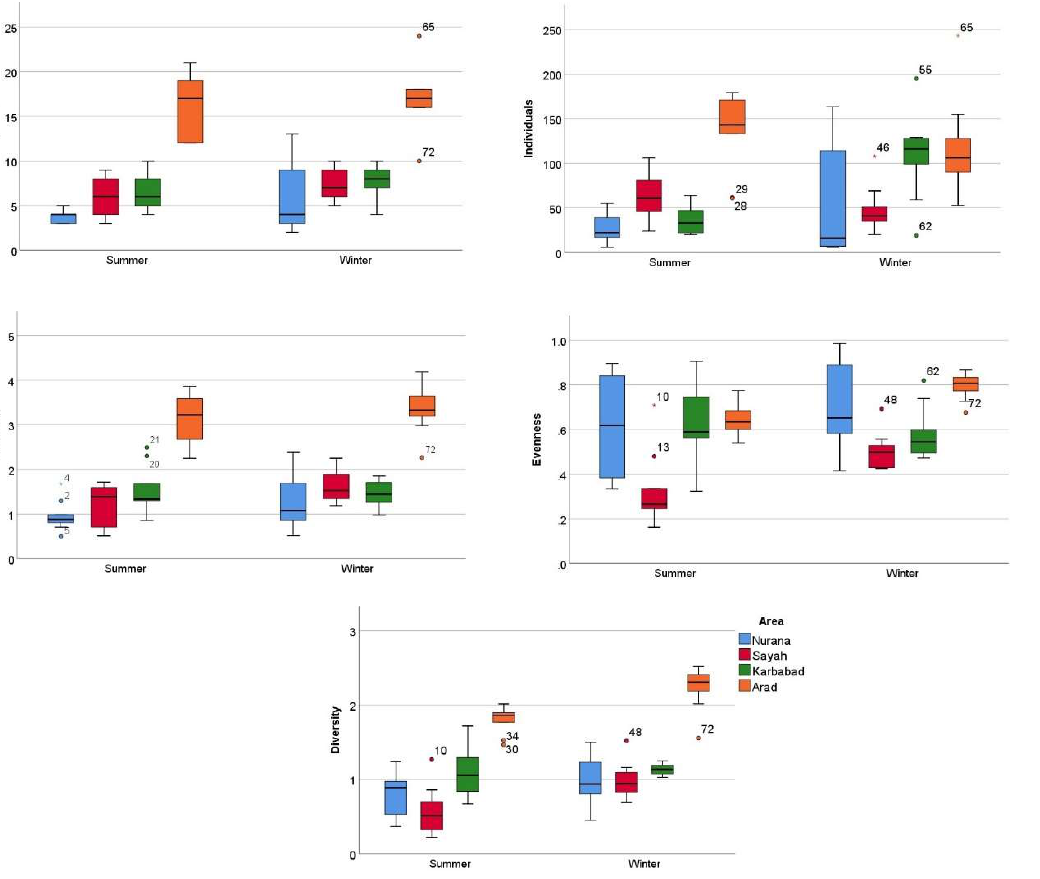
Figure 5. Ecological indices in the four sampling areas in the summer and winter seasons, presented as the median and interquartile range.